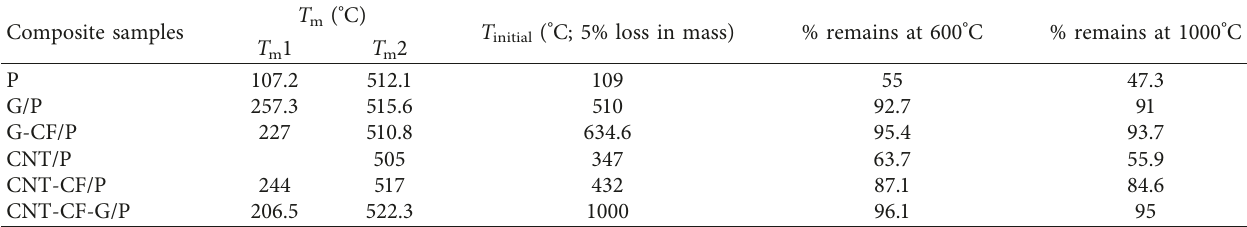
° C and 1000 ° C, for P resin and its nanocomposites.